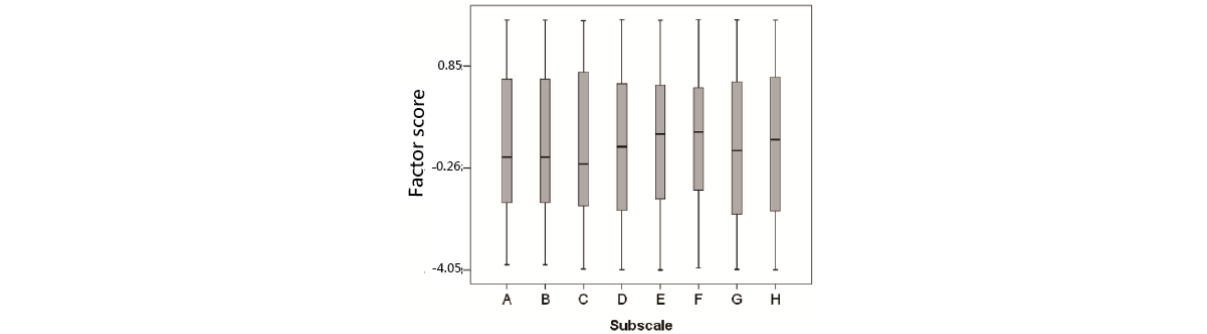
Figure 3. Eight domains using factor analysis to classification.